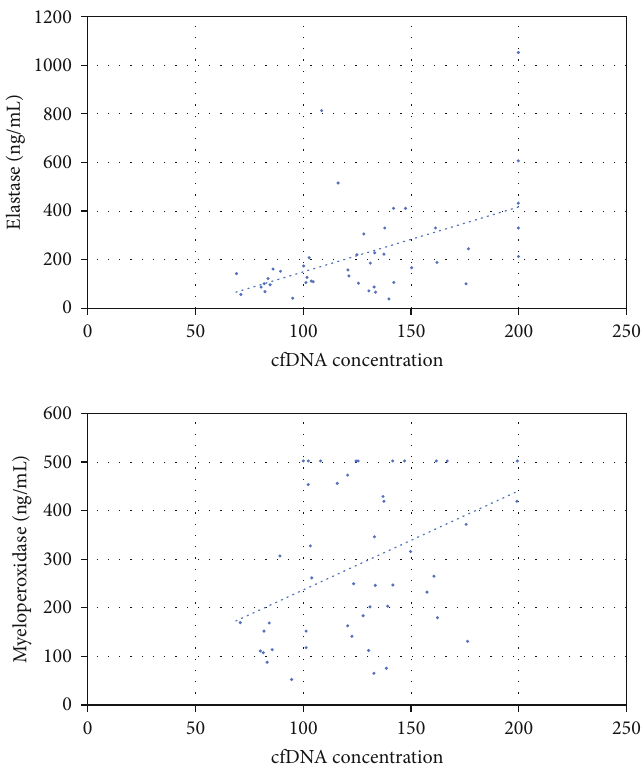
Figure 2: Scatter plots for cell-free DNA concentration (cfDNA) and elastase ( r = 0 : 521 ; p < 0 : 001 ) and myeloperoxidase (MPO) levels ( r = 0 : 438 ; p = 0 : 002 ). Dotted blue lines represent the linear